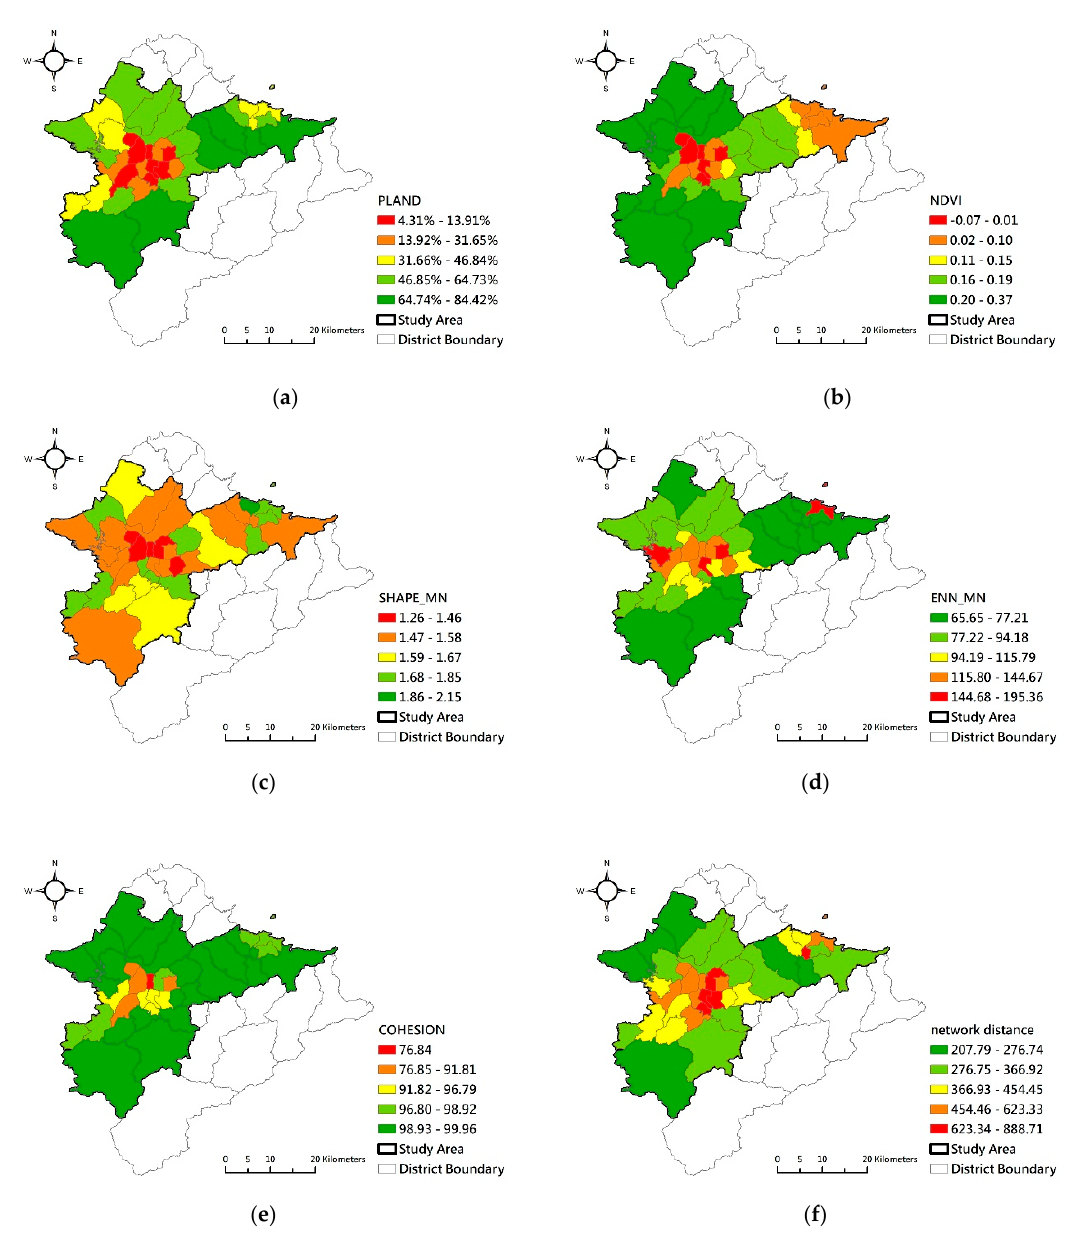
Figure 3. Landscape spatial patterns and distribution of urban green spaces. ( a ) proportion of green spaces (PLAND); ( b ) normalized difference vegetation index (NDVI); ( c ) shape of UGS (SHAPE_MN); ( d ) mean distance of UGS patches to the nearest residential patch (ENN_MN); ( e ) continuity of UGS patches (COHESION); ( f ) Network Distance.